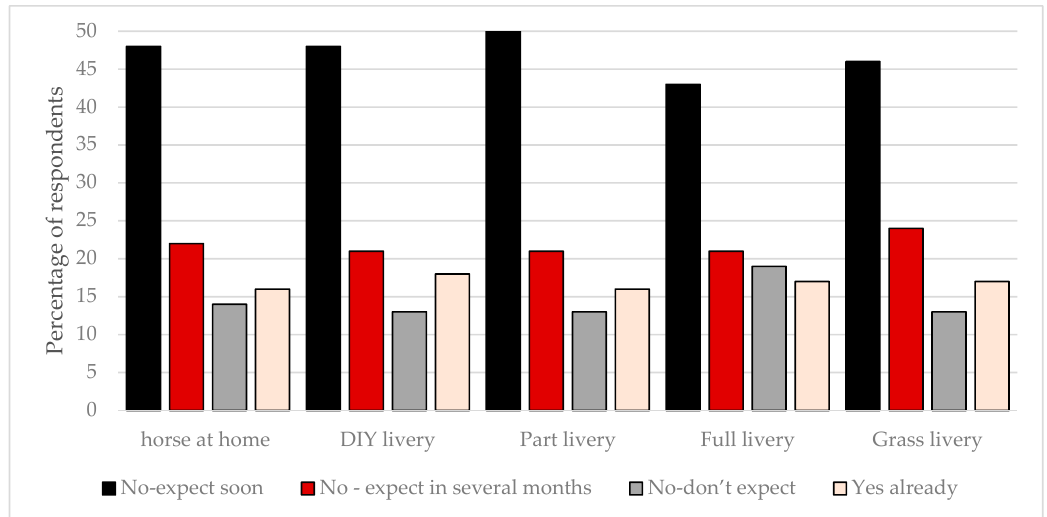
Figure 4. The extent to which changes to professional services for horses e.g., veterinarian, farrier, equine dentist, and physiotherapist, related to COVID-19 affected horse health. Respondents were asked to select the option that they felt best fitted their expectations for how the COVID-19 pandemic would affect their access to common professional services and subsequently their horse/s health. The data are reported by establishment type.